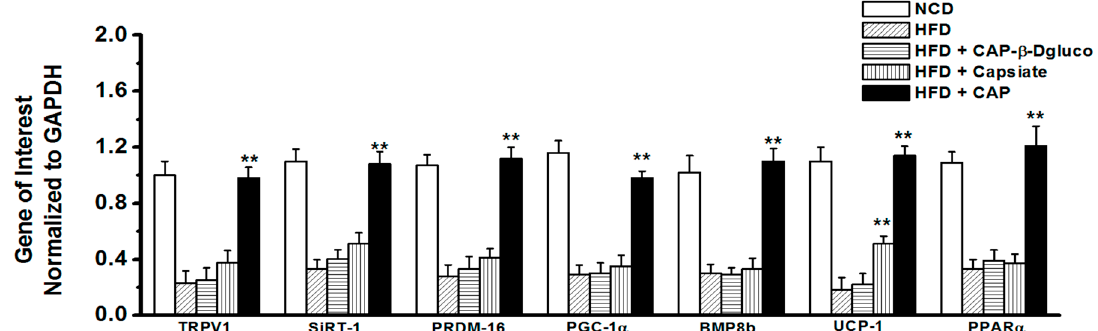
Figure 3. Effect of CAP- β -Dgluco, Capsiate, and CAP on mRNA levels of surrogate thermogenic markers. Mean mRNA levels ± SEM of TRPV1, SiRT-1, PRDM-16, PGC-1 α , BMP8b, UCP-1, and PPAR α in the inguinal WAT of NCD or HFD ( ± CAP, Capsiate or CAP- β - D gluco)-fed wild type mice. ** represent statistical significance for p < 0.05 for n = 4 independent experiments/condition.